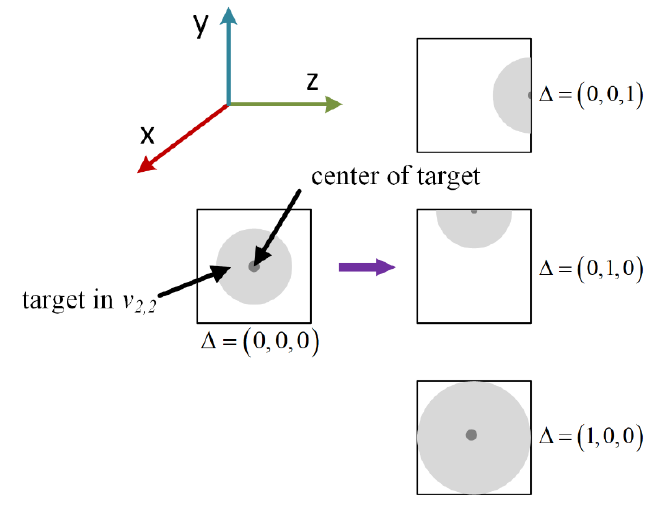
Figure 8. Definition of the parameter Δ.